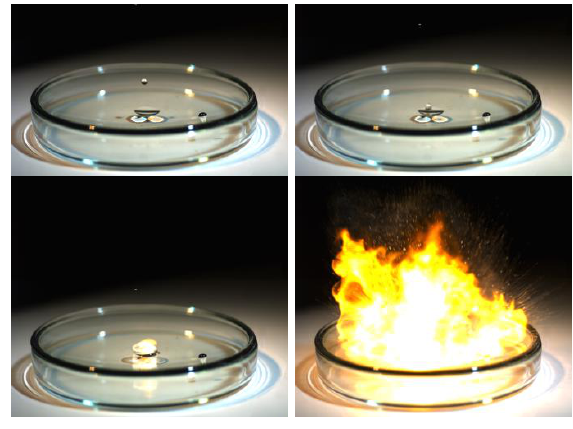
Fig. 4. Drop test of the triglyme-HTP pair; frames obtained at –5, 0, 5 and 10 ms after the contact of the HTP droplet with the triglyme pool